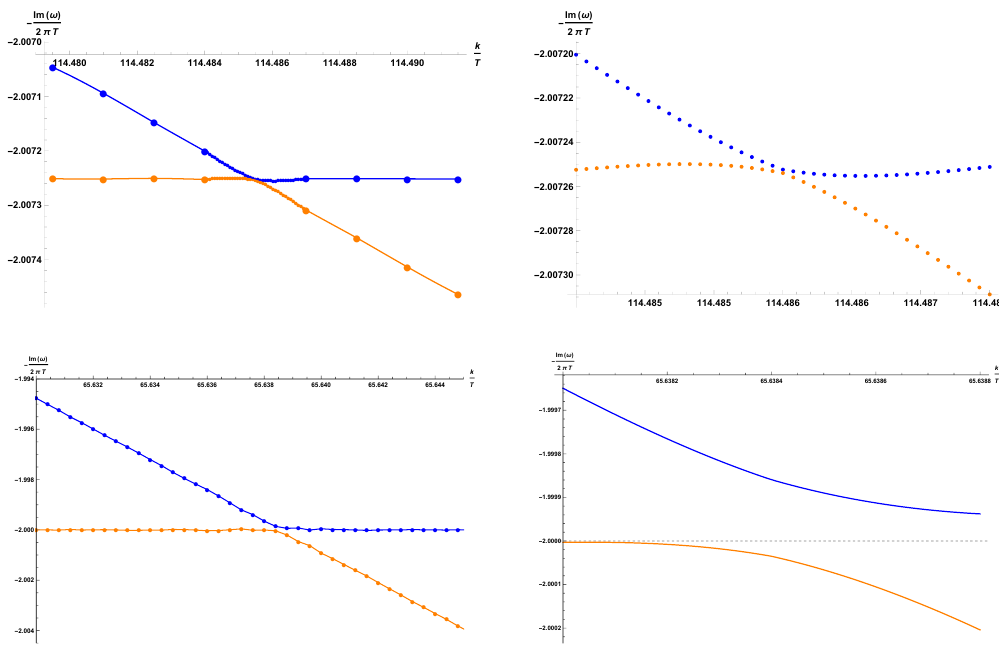
Figure 4 . Top left: the “almost” collision between the diffusive mode and the first non- hydrodynamic mode. Top right: a zoom of the avoided crossing dynamics for N = 3 and m/T = 900 . The gap between the two modes becomes smaller and smaller going to lower temperature. Bottom panels: the same figures at larger temperature, m/T = 300 . Here, the avoided crossing is more pronounced and the separation between the two curves is larger. This implies that the imaginary part of the critical complex momentum is